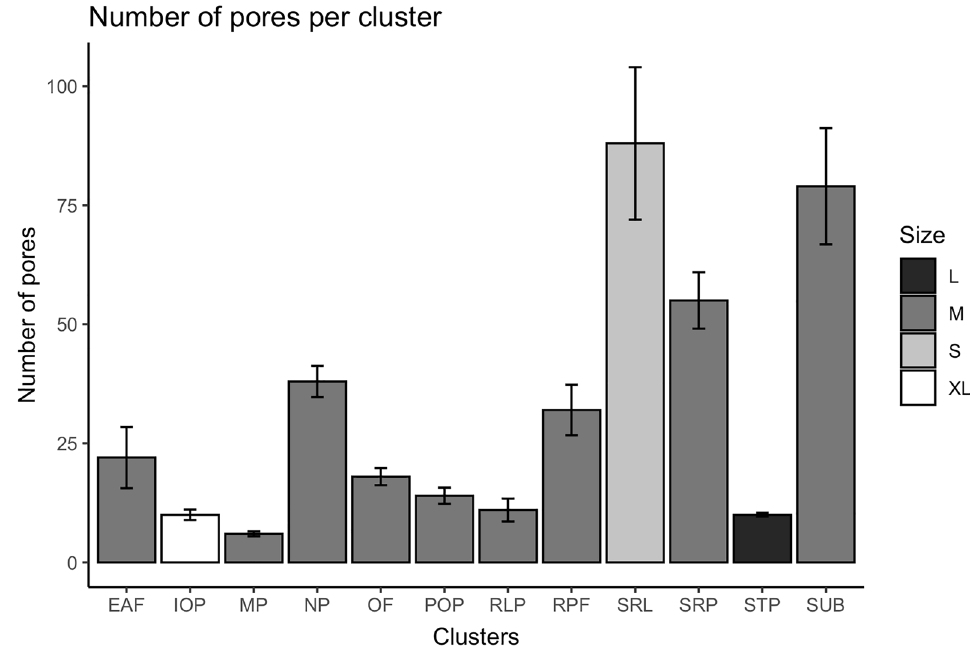
Figure 3. Histogram of the average number of pores for each cluster. For the cluster which are double (present in the same position on both sides of the head) the number of pores here represented is for only one cluster. Four shade of grey indicate the size of the pore. XL: extra-large sized pore (average size larger than 1 mm); L: large sized pores (average size between 0.9 and 1.0 mm); M: medium sized pores (average size between 0.3 and 0.6 mm); S: small sized pores (average size smaller than 0.3 mm). The choice of these different classes of size depends on the ANOVA and Tukey test performed (see Fig. 3), which indicate a statistically significant difference of the average size of IOP (1.2 mm average pore diameter), SRL (0.2 mm average pore diameter), and STP (0.9 mm average pore diameter) clusters among them and among all other clusters. EAF: ethmoid cluster; IOP: infraorbital cluster; MP: mandibular cluster; NP: nasal cluster; OF: oral cluster; POP: preorbital cluster; RLP: rostrolateral cluster; RPF: rostral cluster; SRL: supra-rostrolateral cluster; SRP: suprarostral cluster; STP: supratemporal cluster; SUB: subrostral